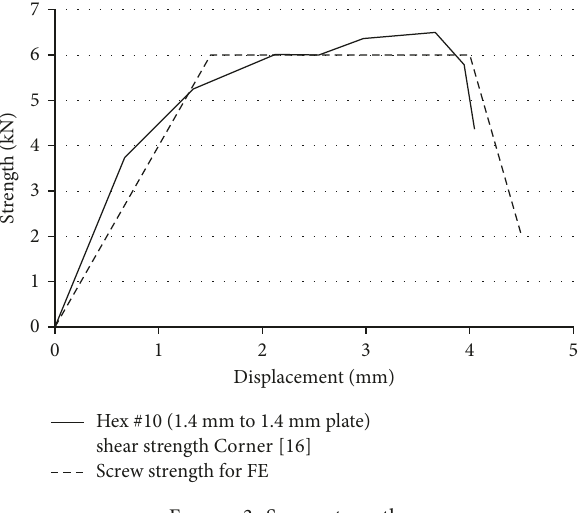
Figure 1: SHELL181 formulation.